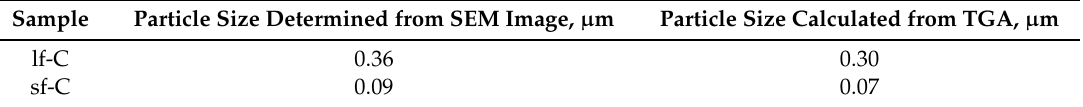
Table 2. Comparison of two methods for the calculation of particle